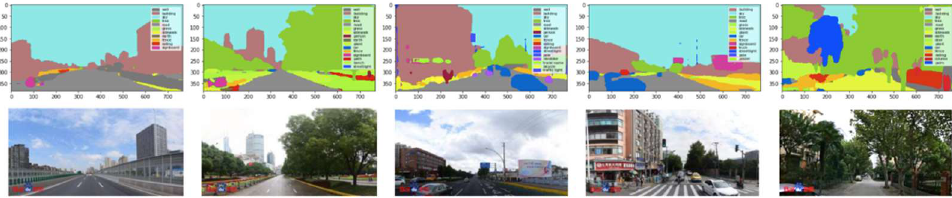
Figure 5. Five random sample results achieved by computer vision (CV) segmentation. Pairwise photos demonstrate semantic segmentation results and the raw SVIs.